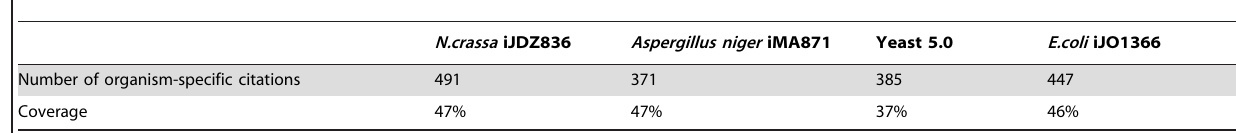
Table 1. Comparison of curation level among selected metabolic